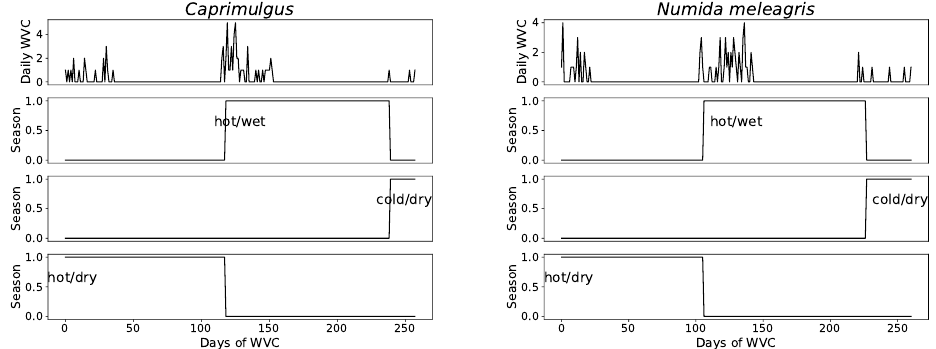
Figure 8. Taxonomic wildlife roadkill daily data showing the endogenous and exogenous variables on the Aves (top-left panel), Mammalia (top-right panel), Caprimulgus (bottom-left panel), and Numida meleagris (bottom-right panel)